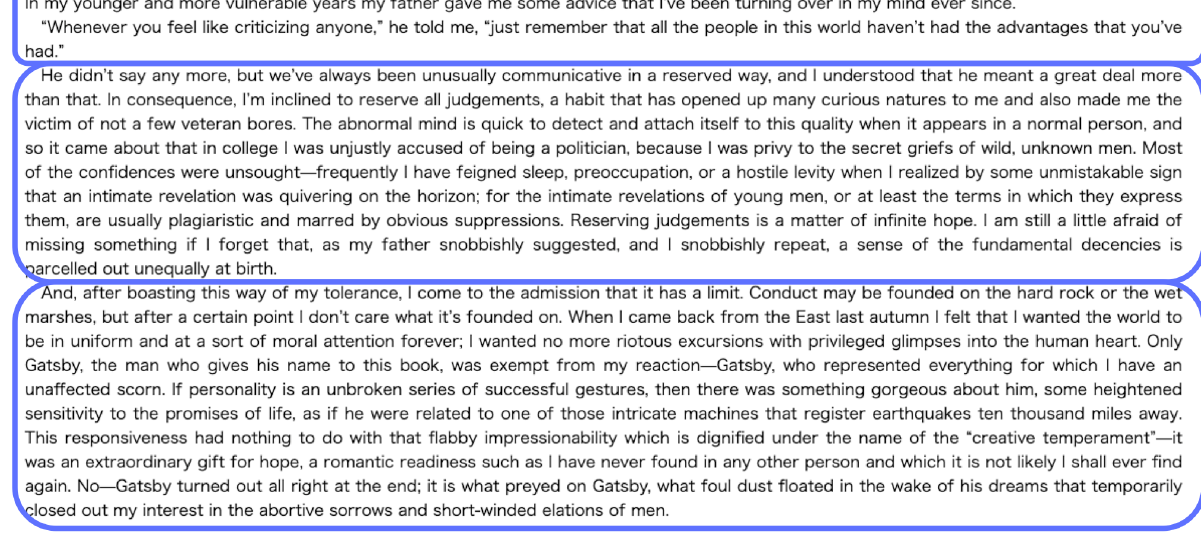
Figure 1. An illustration of a paragraph extracted from a sample novel ( The Great Gatsby by F. Scott Fitzgerald). The part surrounded by the purple line is a paragraph. Conversational sentences were not counted as independent paragraphs.